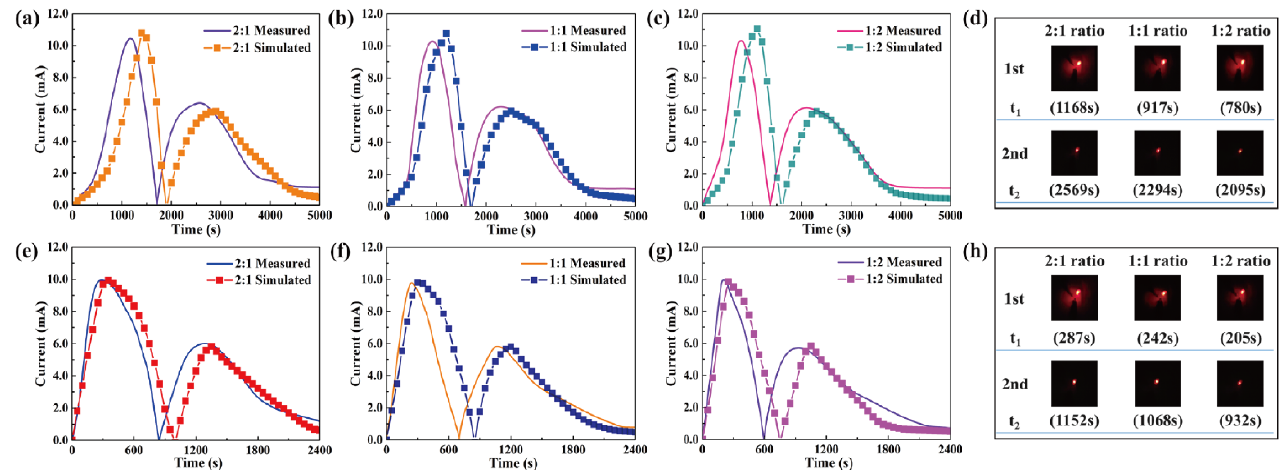
Figure 9. Experimental results and numerical calculations during heating for ( a ) 2:1 ratio PCM composites, ( b ) 1:1 ratio PCM composites and ( c ) 1:2 ratio PCM composites. ( d ) LED bulb images upon heating. Cooling results of ( e ) 2:1 ratio PCM composites, ( f ) 1:1 ratio PCM composites and ( g ) 1:2 ratio PCM composites. ( h ) LED bulb images upon cooling.